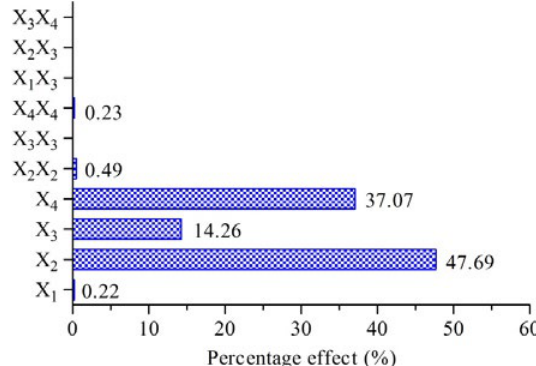
Fig. 5: Pareto graphic analysis for the percentage effect of the investigated factors Fig. 4: Residual plots for the response: normality plot (a) and residual versus fitted result (b)